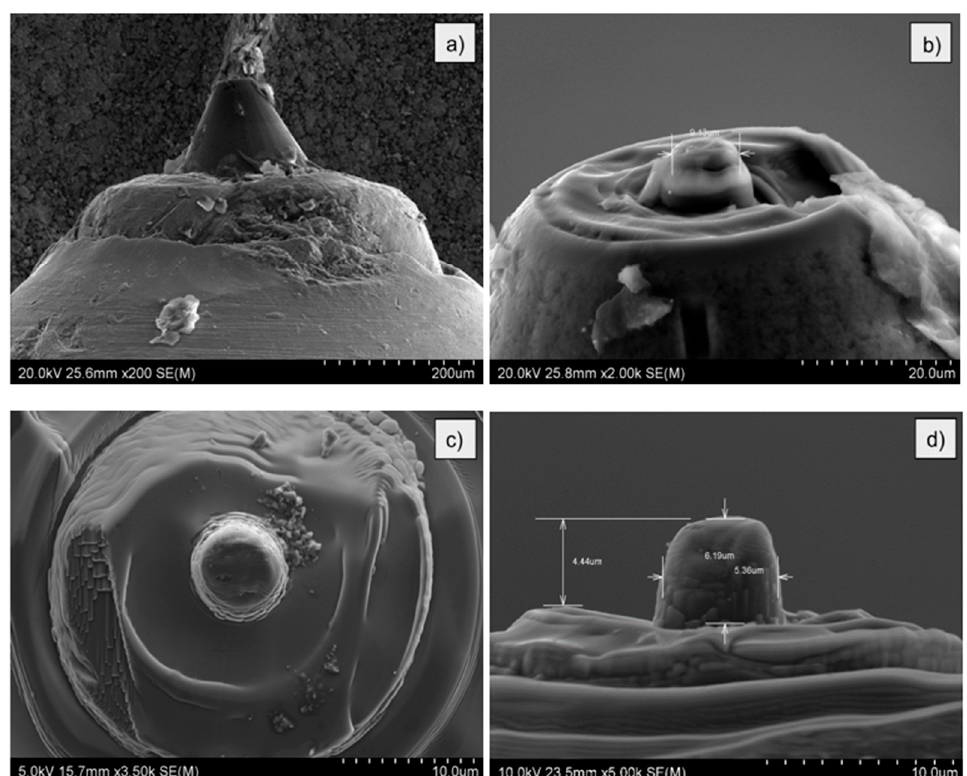
Figure 3. Images of the intender processing stages: ( a ) general view; ( b ) start of cutting process; ( c , d ) final result with indicated intender geometry.